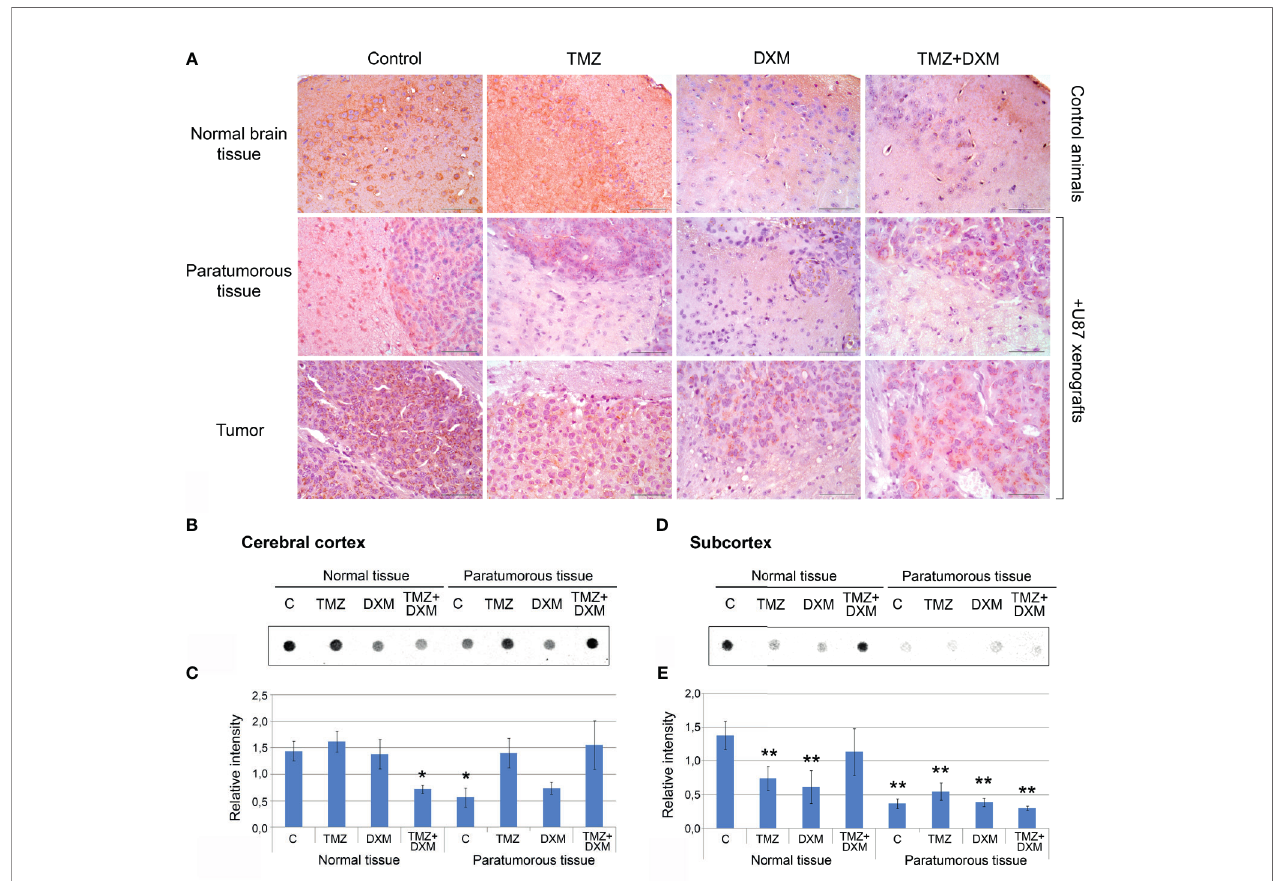
FIGURE 5 | Chondroitin sulfate content in SCID mice brain tissues before and after treatments with TMZ and/or DXM. (A) Immunohistochemical analysis of CS content before and after TMZ/DXM treatments in normal SCID mouse brain tissue, paratumorous tissue and U87 xenografts. Magni fi cation *400. Scale bars 50 µm. (B – E) Dot-blot analysis of the total CS content using anti-CS antibody in cortex and subcortex structures. (B, D) Original representative dot blots. (C, E) Semi- quantitative analysis of the dot-blots (ImageJ 1.52 software). Bars represent the mean ± SD from triplicate experiments (OriginPro 8.5). ANOVA + Fisher ’ s LSD test, *p < 0.05, **p < 0.01. Control, non-treated mouse brain tissue; TMZ, temozolomide; DXM,